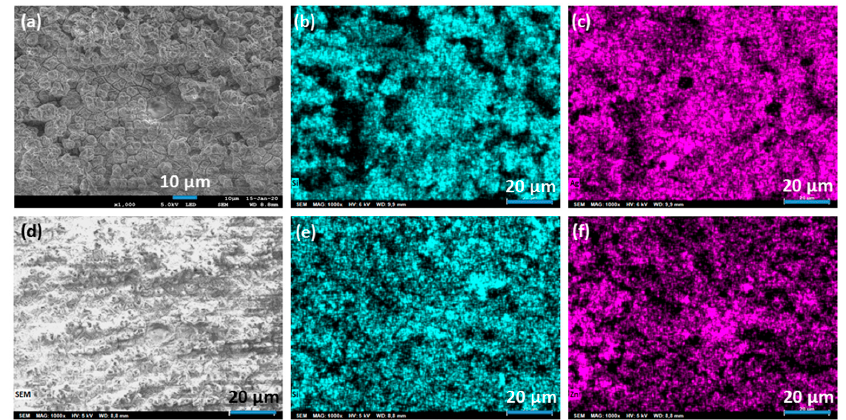
Figure 5. SEM images of FAU-zeolite membranes exchanged with silver ( a ) or zinc ( d ) and Energy Dispersive X-ray (EDX) mapping of silicon ( b , e ), silver ( c ) and zinc ( f ) elements present in these FAU-zeolite membranes.